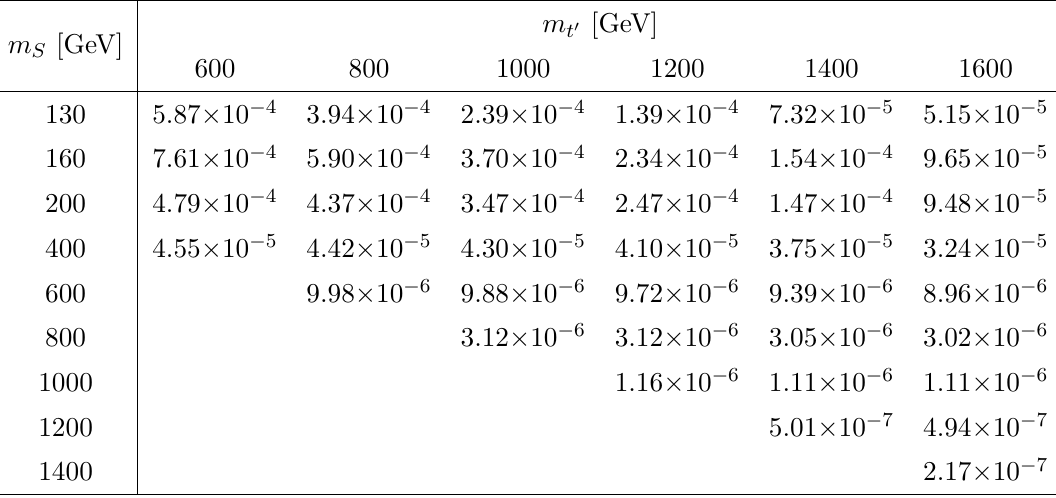
Table 7 . The background cross section times e(cid:14)ciency (cid:27) B the Z (cid:13) signal